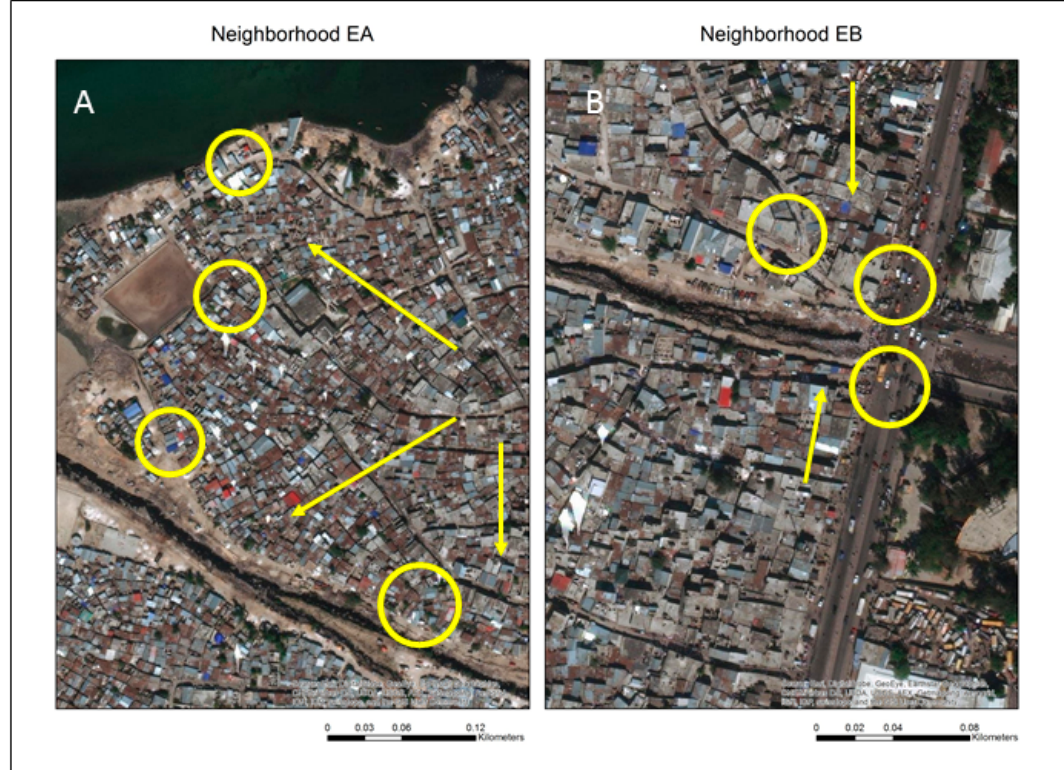
Figure 7. Generalized locations of high risk sample sites in the EA and EB neighborhoods. Arrows indicate the increases in contamination the closer the site is to either the Bois de Chêne canal ( A and B ) or the coastal edge ( A ).